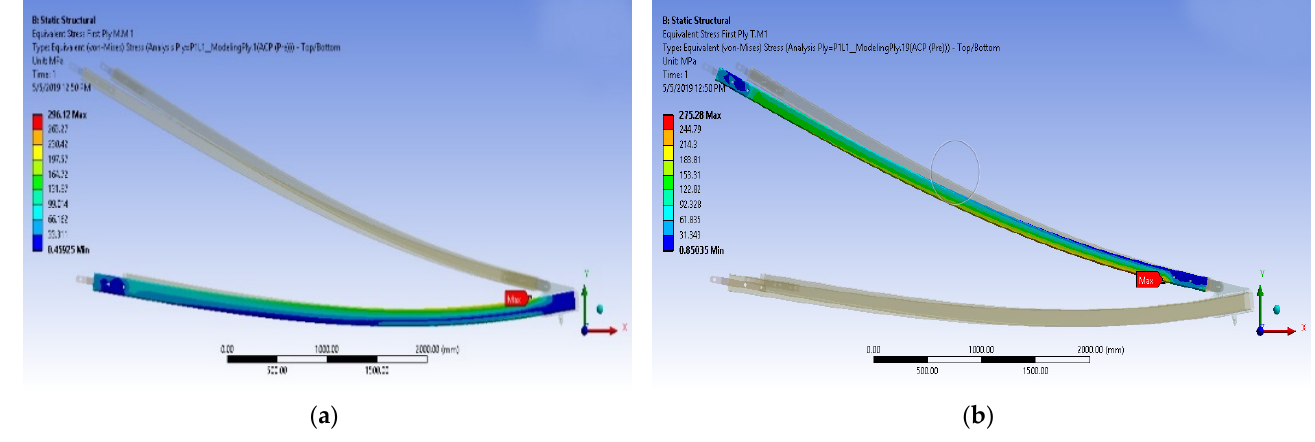
10 of 19 Figure 7. Deformation and Factor of Safety (FOS) for GFRP cross ‐ arm (Normal condition). Figure 8a,b show the maximum deformation; equivalent stress first ply for the main